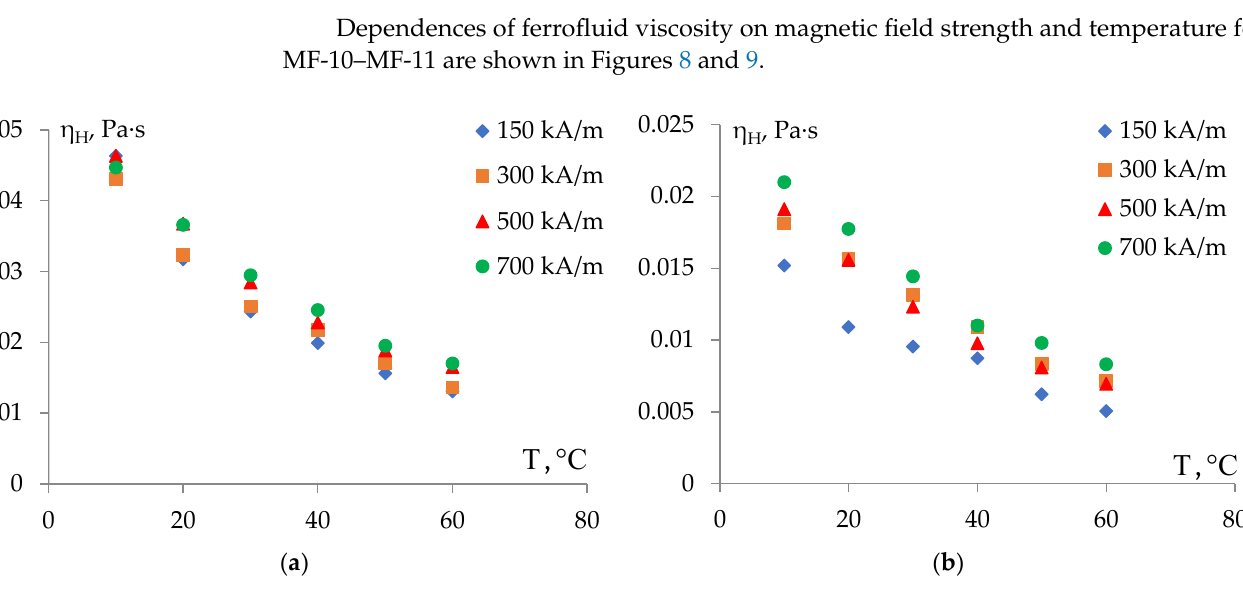
Figure 8. Dependence of the ferrofluid viscosity on temperature: ( a ) MF-10, ( b ) MF-11.